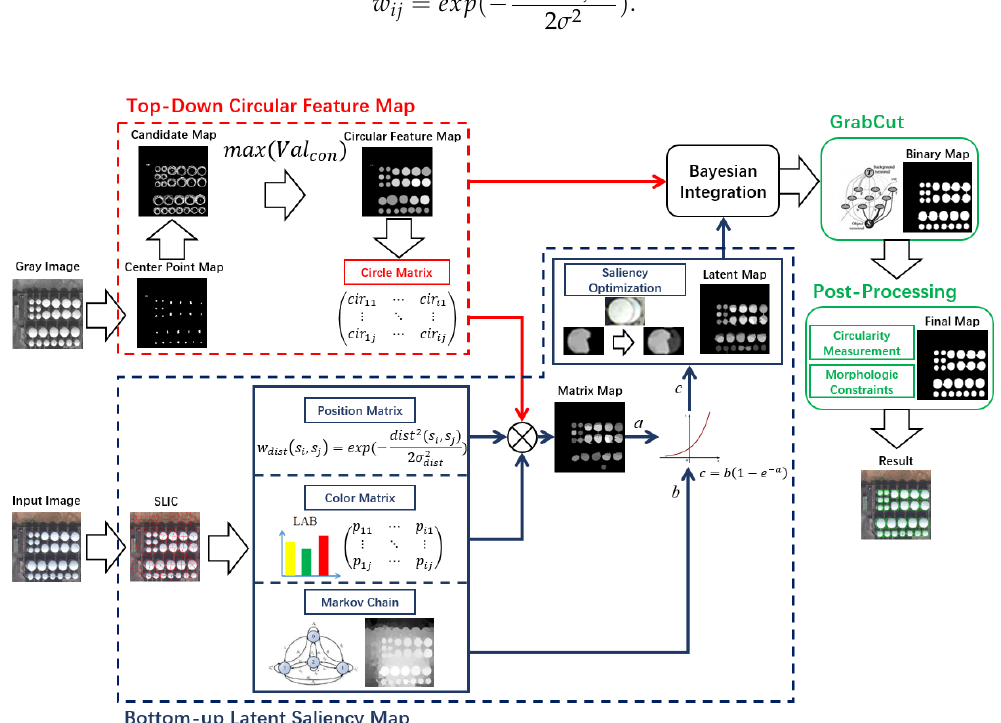
Figure 1. Flowchart of the unsupervised saliency model with Color Markov Chain (US-CMC) method. First, a bottom-up latent saliency model combined with a circle matrix was applied to get the latent map. At the same time, the radial symmetry method was used to get the circular feature map then combine both maps by using Bayesian integration. Then, after One Cut for GrabCut and post-processing, the final result was